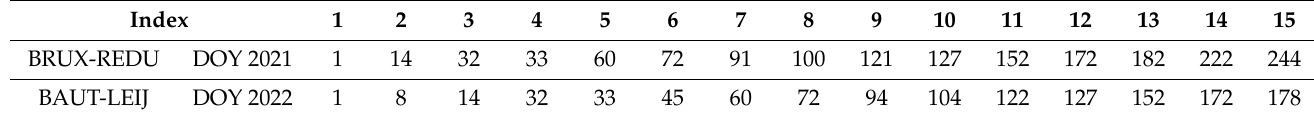
Figure 13. ZPD difference between BAUT and LEIJ.